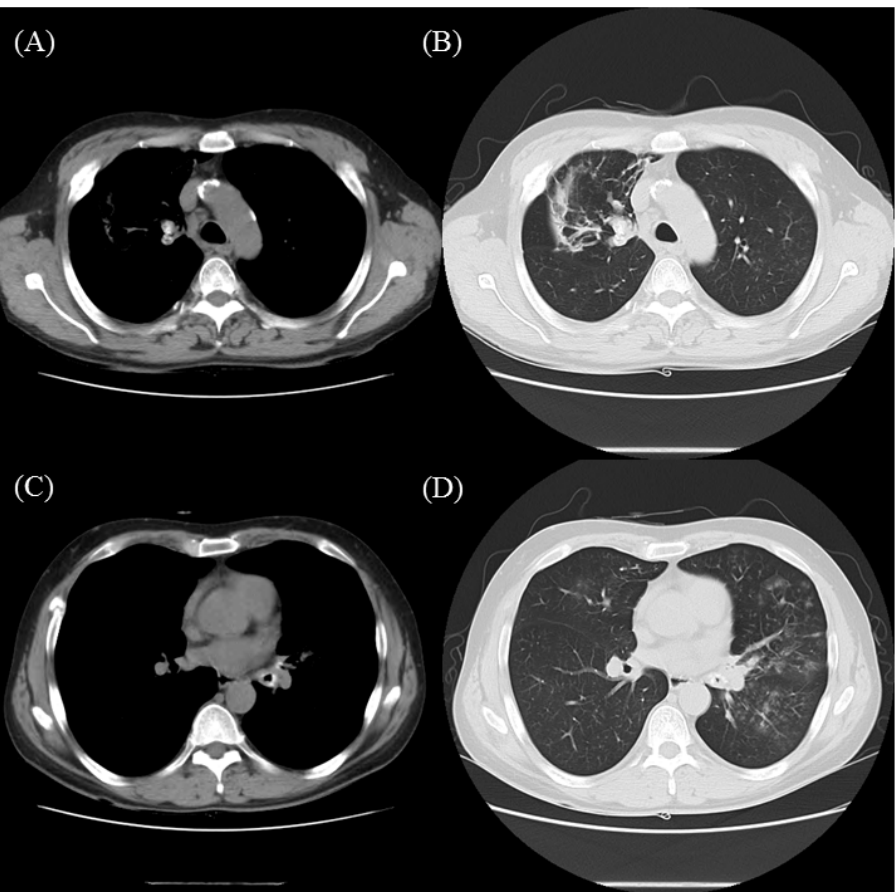
Figure 1: (A) Chest computed tomography shows an irregularly narrowed bronchus wall with a small polypoid mass attached to the right upper lobar (RUL) bronchus. (B) Peribronchial consolidation with cystic and tubular bronchiectasis, mucoid impactions and multiple cen- trilobular nodules are seen with patchy ground glass opacities in RUL area. (C) Luminal narrowing is shown due to irregular calcified wall thickening in left upper and lower lobar bronchi. (D) There is associated obstructive pneumonitis with some infiltrative opacities involving lingular segments of left upper lobe and superior segment of left lower lobe.